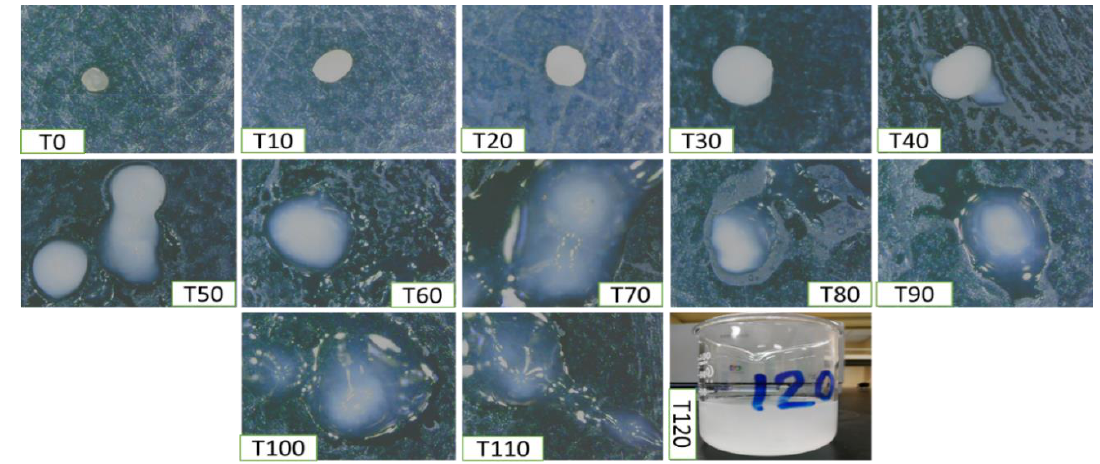
Figure 11. Swollen alginate-BSO bead characterization comprised of evidence on its thickness and graphic appearance in alkaline media (pH 6.8) using a digital camera. Magnification at 50×.